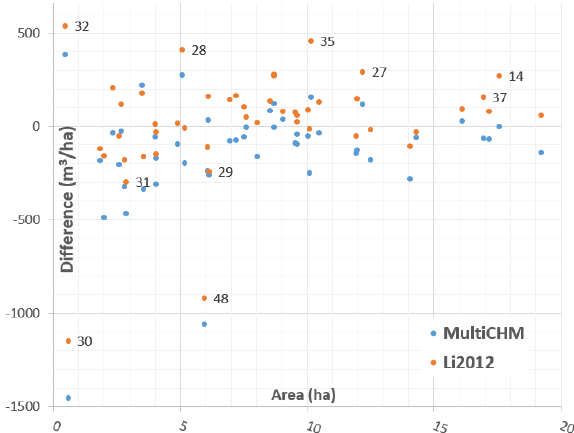
Figure 3. Distribution of differences over area